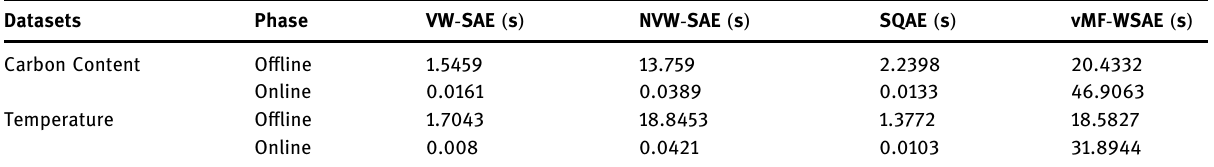
Table 9: Performance comparison of the proposed method and other experiments in terms of computation time Datasets